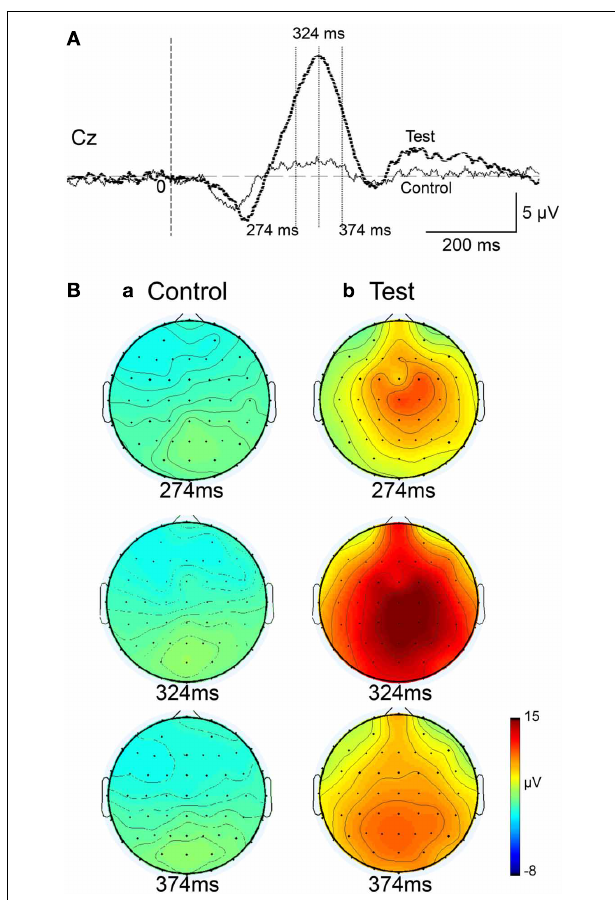
FIGURE 5 | Topographical maps of the averaged ERPs at latencies surrounding the ERP peak latency. Latencies of examined ERPs are shown in (A) . The three topographical maps are indicated in (B) : three topographical maps of the ERPs in the control (a) and test (b) phases.